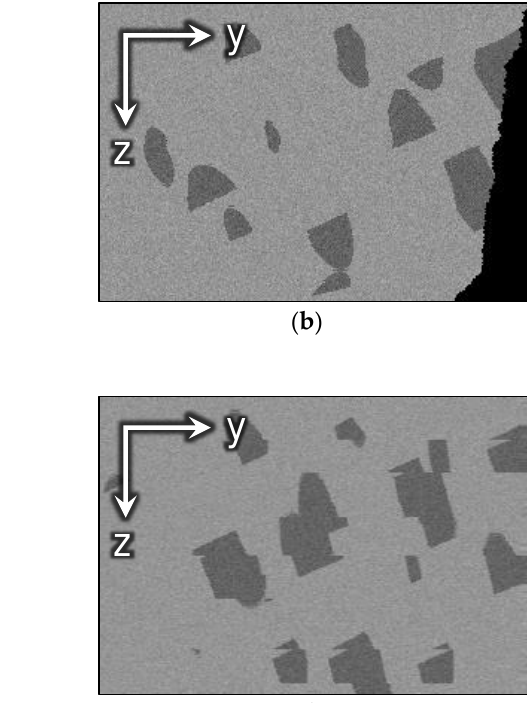
Table 1. Alignment metrics for the synthetic sample.